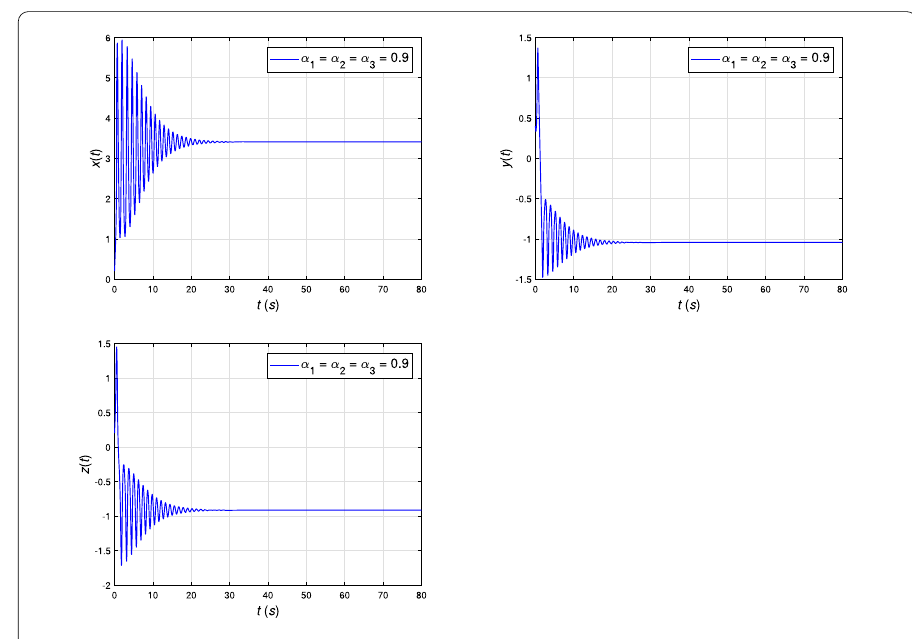
Figure 3 State variables of the fractional-order model (21) in the time-domain ( α i = 0.9, i = 1,2,3)